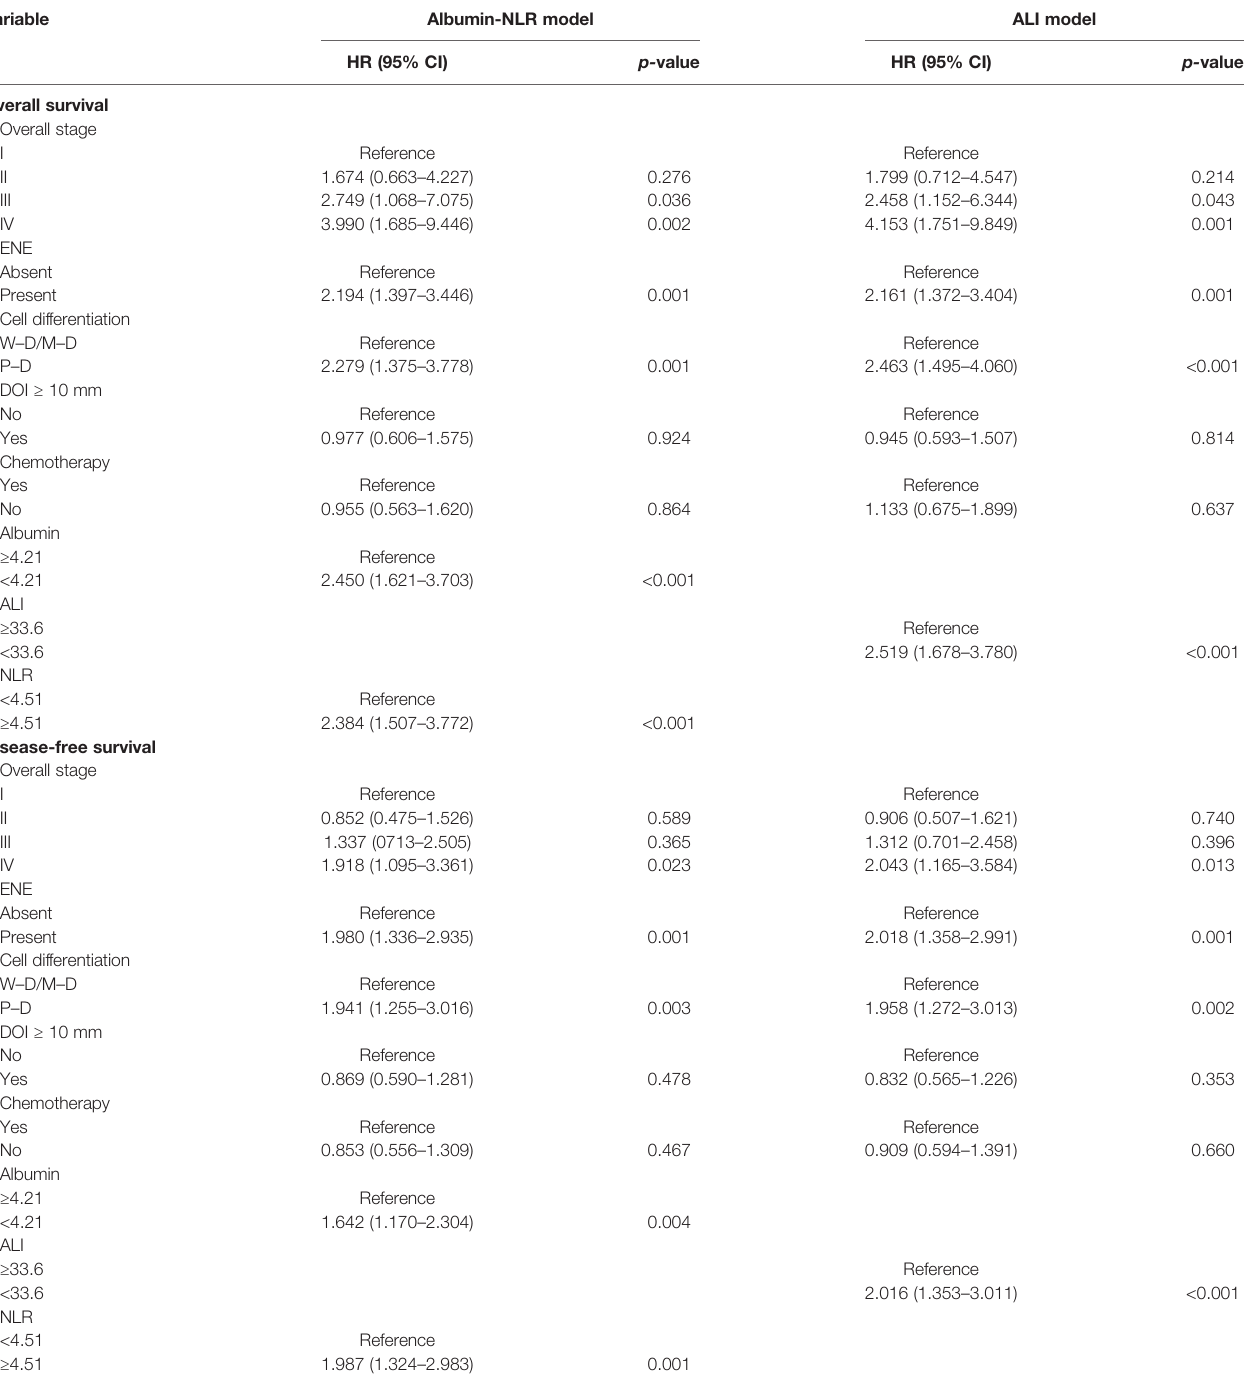
TABLE 5 | Multivariate analysis of poor prognostic factors for OS and DFS in OSCC